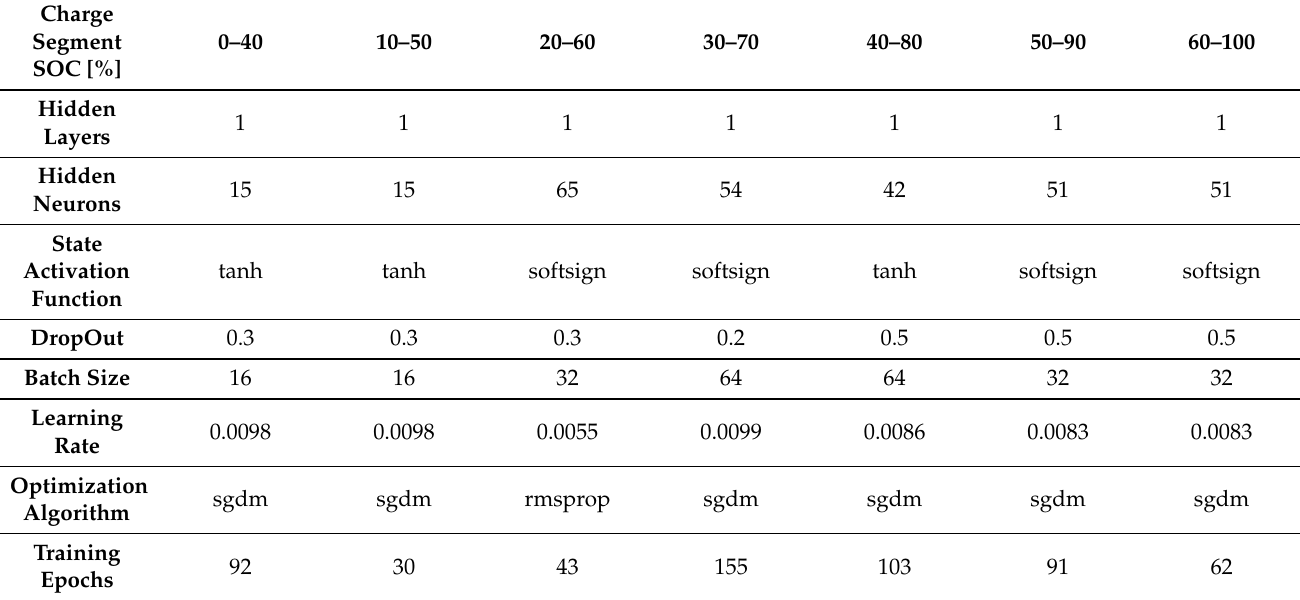
Table 6. Analysis #3: Best neural network training and architecture